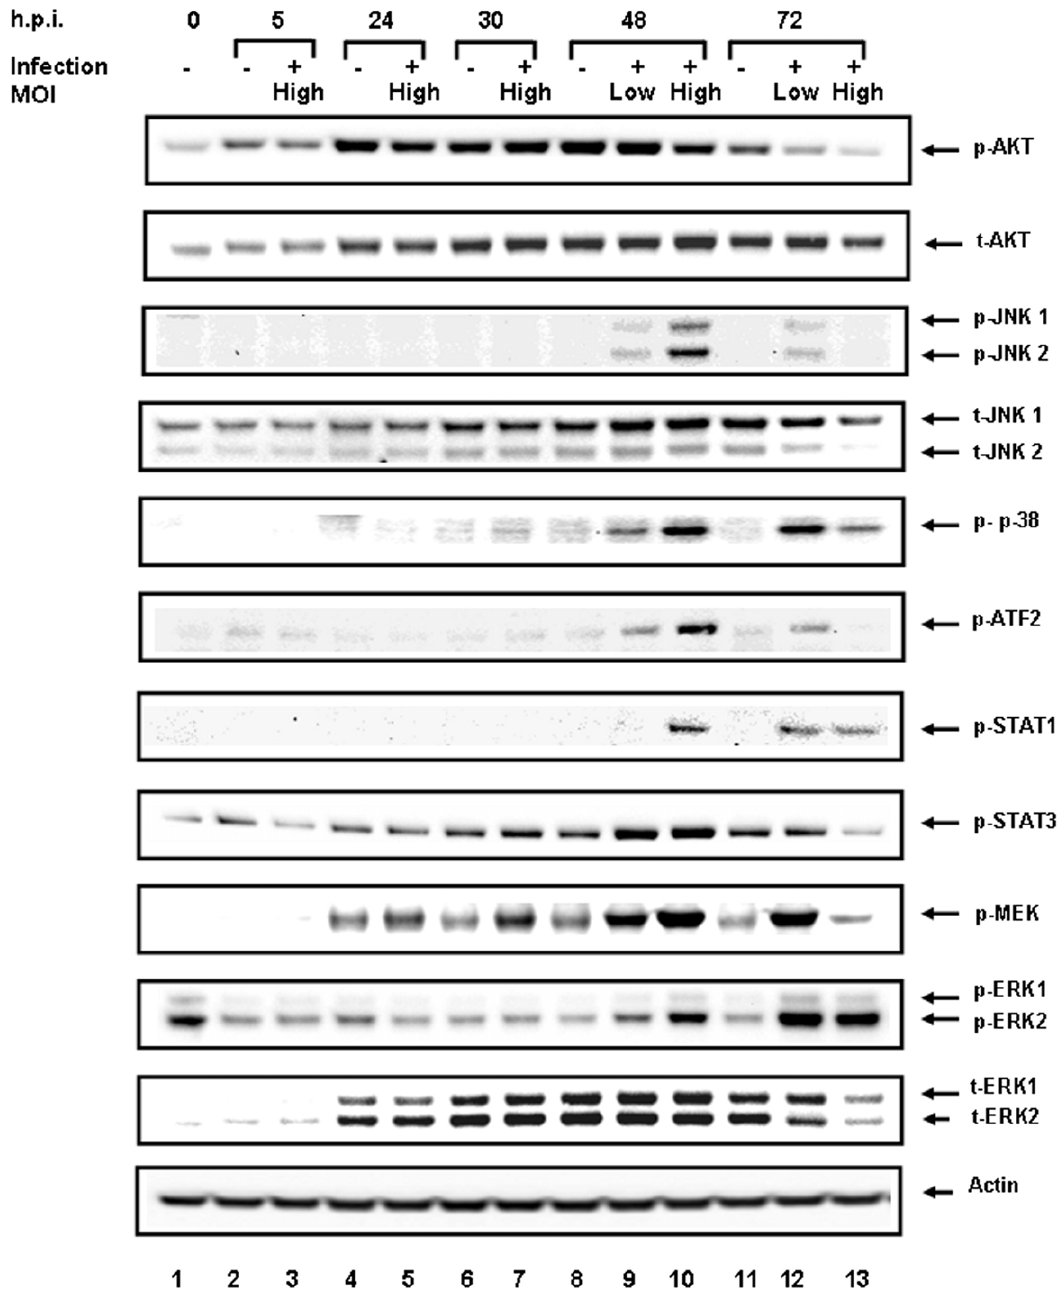
Figure 4. Confirmation of RPMA data by Western blot using antibodies against phosphorylated and total forms of several proteins. Western blots were performed on two independent experiments. The RVFV-infected HSAECs with MOI of 0.002 and 0.0002 at corresponding time points are indicated with a + sign. Samples 1, 2, 4, 6, 8 and 11 are from untreated cells at 0, 5, 24, 30, 48 and 72 h.p.i. and samples 3, 5, 7, 10 and 13 are RVFV- infected HSAECs with MOI of 0.002 at 5, 24, 30, 48 and 72 h.p.i. Samples 9 and 12 correspond to the cells infected with MOI of 0.0002 at 48 and 72